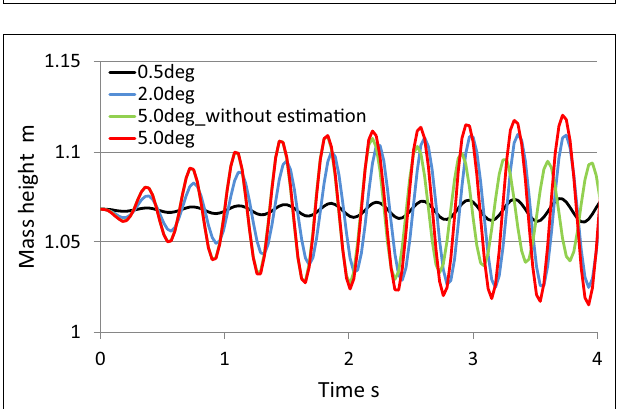
FIGURE 9 | Degrees of freedom (DOF) of the developed running robot with a 2-DOF running guide . The robot motion was restricted to the vertical and horizontal directions with the developed guide. It had two passive joints and was connected to the robot’s body to allow the robot to go around the guide.